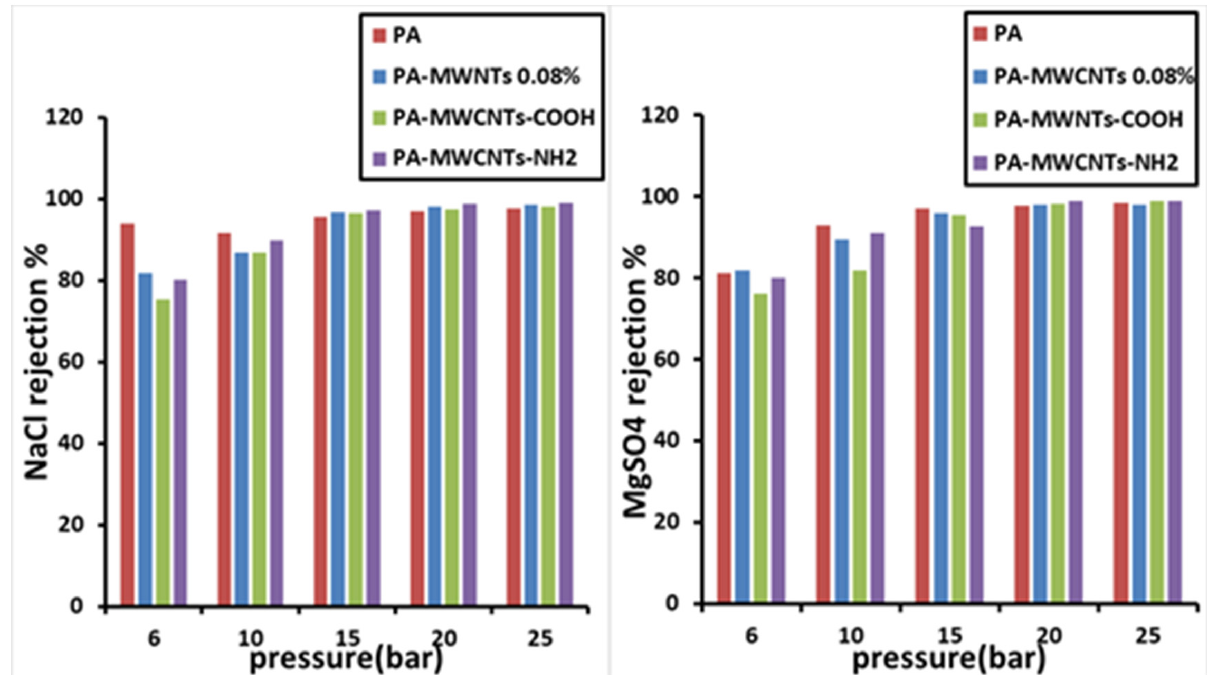
Figure 14. Salt rejection of PA, PA-MWCNTs (0.08%, 0.1%, and 0.15%) membranes.